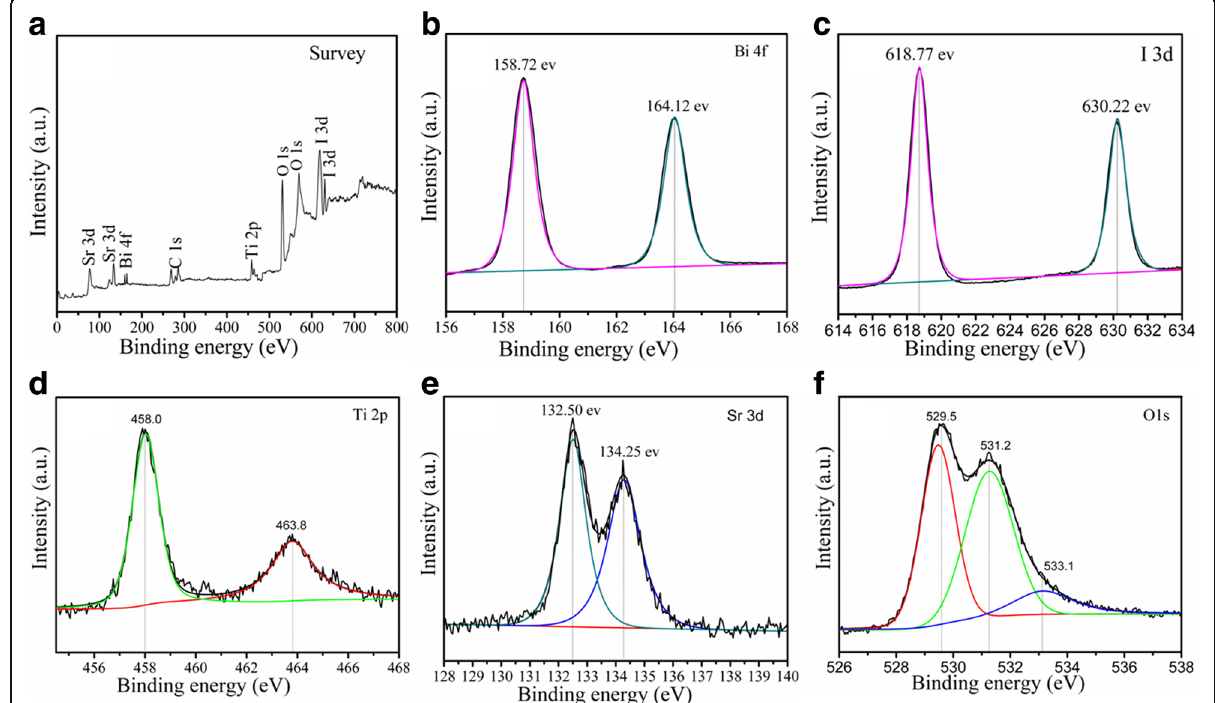
Fig. 2 XPS patterns of the 30 wt% SrTiO 3 /Bi 5 O 7 I nanocomposites: a survey, b Bi 4f, c I 3d , d Ti 2p, e Sr 3d, and f